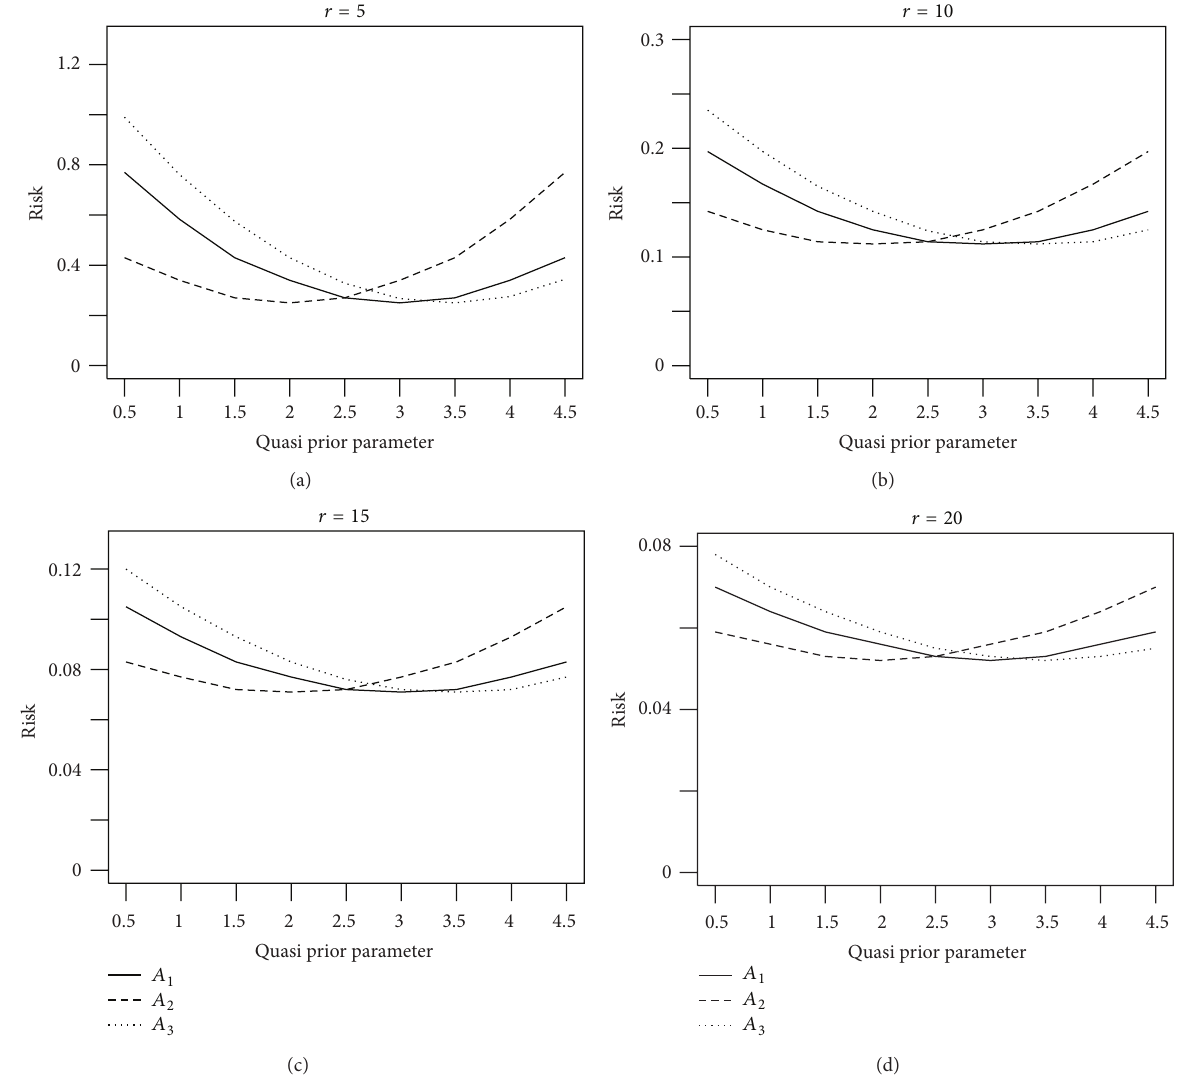
Figure 1: The evolution of risk ratio to 𝛼 2 when 𝑟 = 5, 10, 15 , and 20